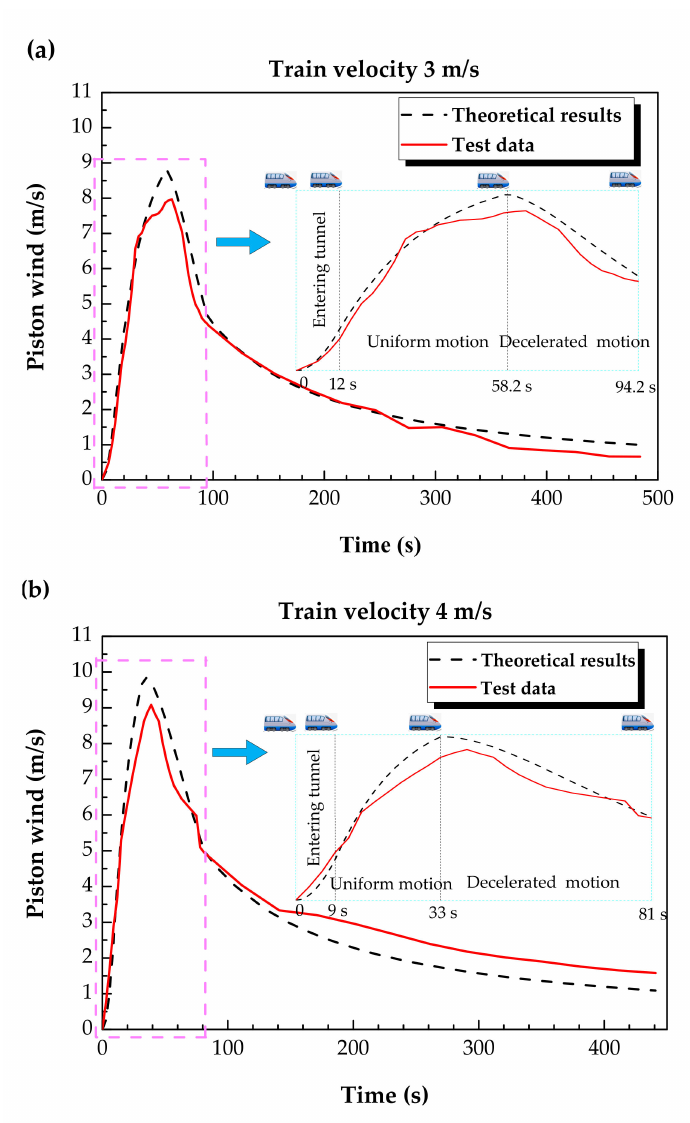
Figure 7. Comparison for theoretical results and test data of piston wind. ( a ) Train velocity 3 m / s. ( b ) Train velocity 4 m /